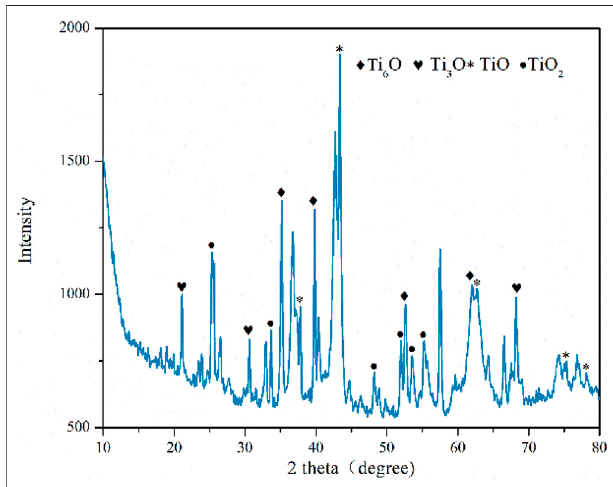
FIGURE 11 | XRD patterns of the oxidation products of the Ti reducing